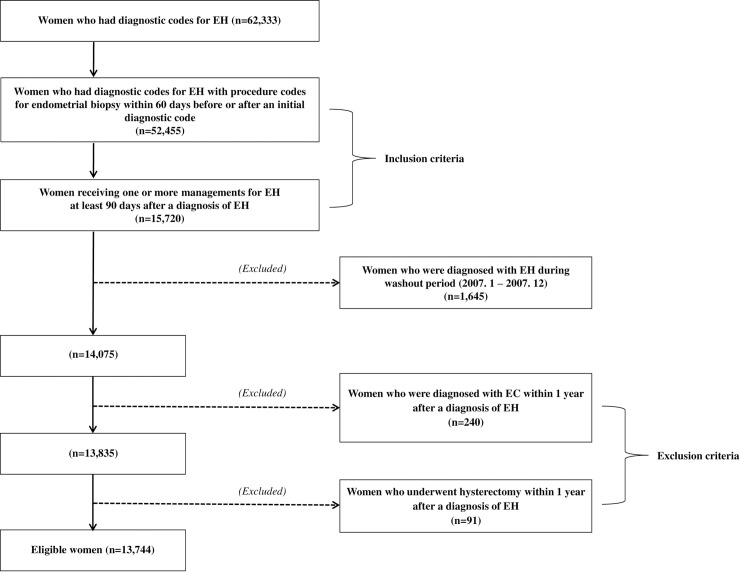
Flow chart showing selection of eligible patients.